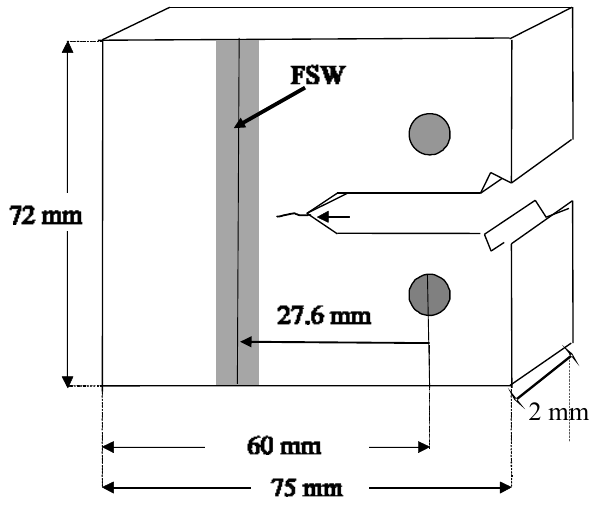
Materials 2020 , 13 , x FOR PEER REVIEW Figure 1. Compact tension (CT) specimen test geometry; from [72]. Figure 1. Compact tension (CT) specimen test geometry; from [72].